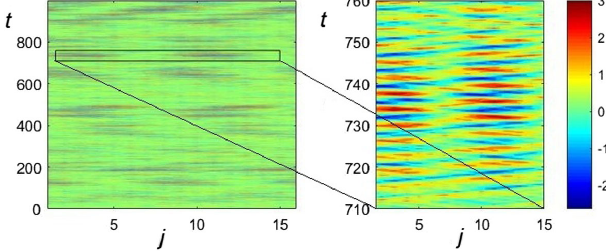
FIG. 8. Color map of the displacement q j ð t Þ for the system with ϵ ¼ 4 . 74 initialized with particles at rest with initial positions as a single sine wave. A nonlinear standing wave pattern is